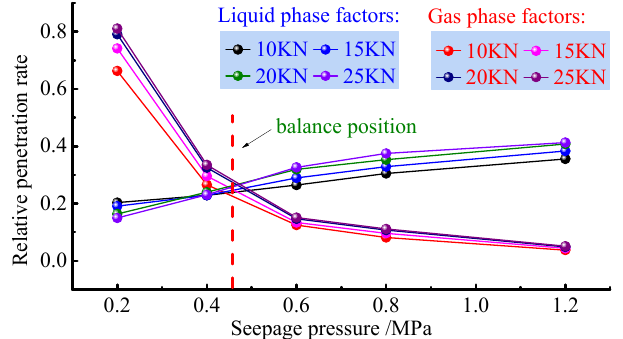
Figure 8. Relationship between relative permeability and seepage pressure.